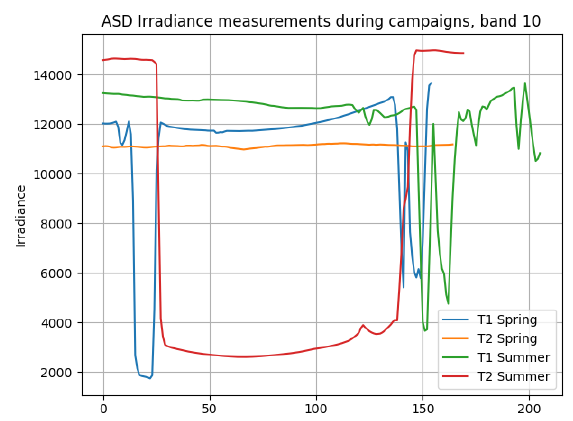
Figure 2. Irradiance measurements with ASD spectrometer during campaigns, FPI band 10. X-axis is incremental FPI